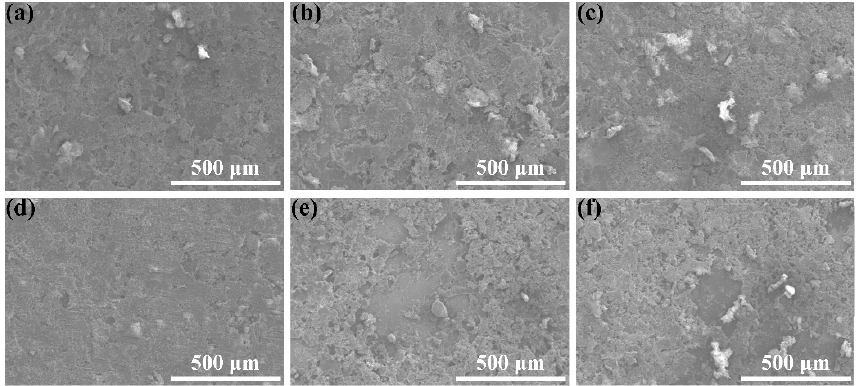
Figure 11. Abrasion morphology of the CSC coating at different CeO 2 (( a ) 0.01 g, ( b ) 0.03 g, ( c ) 0.05 g) and PTFE (( d ) 0.1 g, ( e ) 0.5 g, ( f ) 0.7 g) contents.